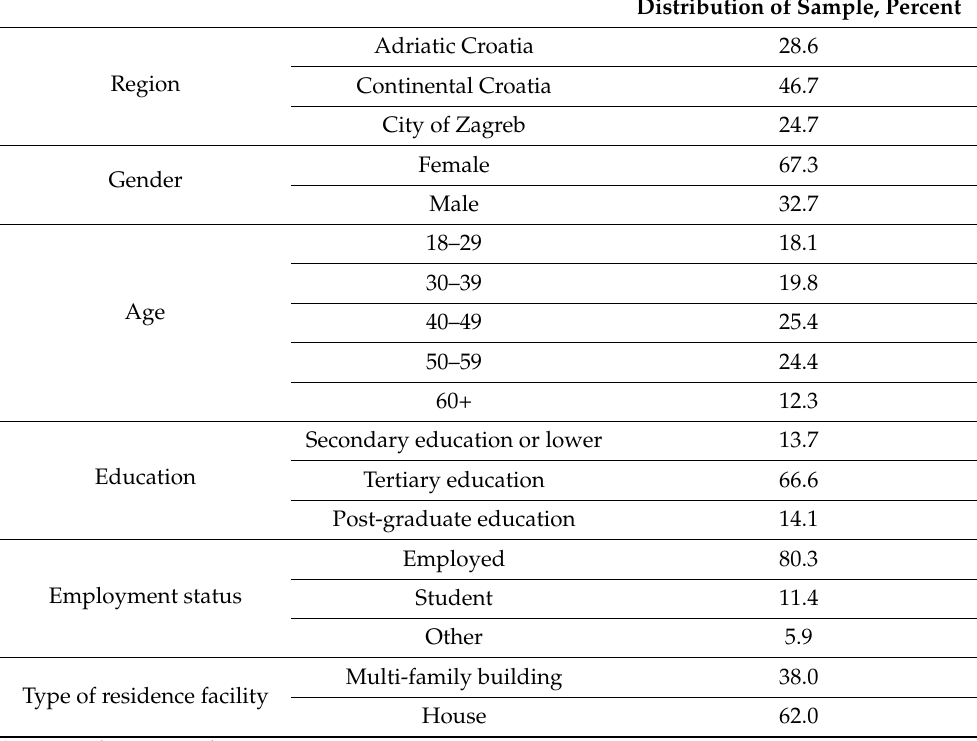
Table 1. Distribution of sample, N =